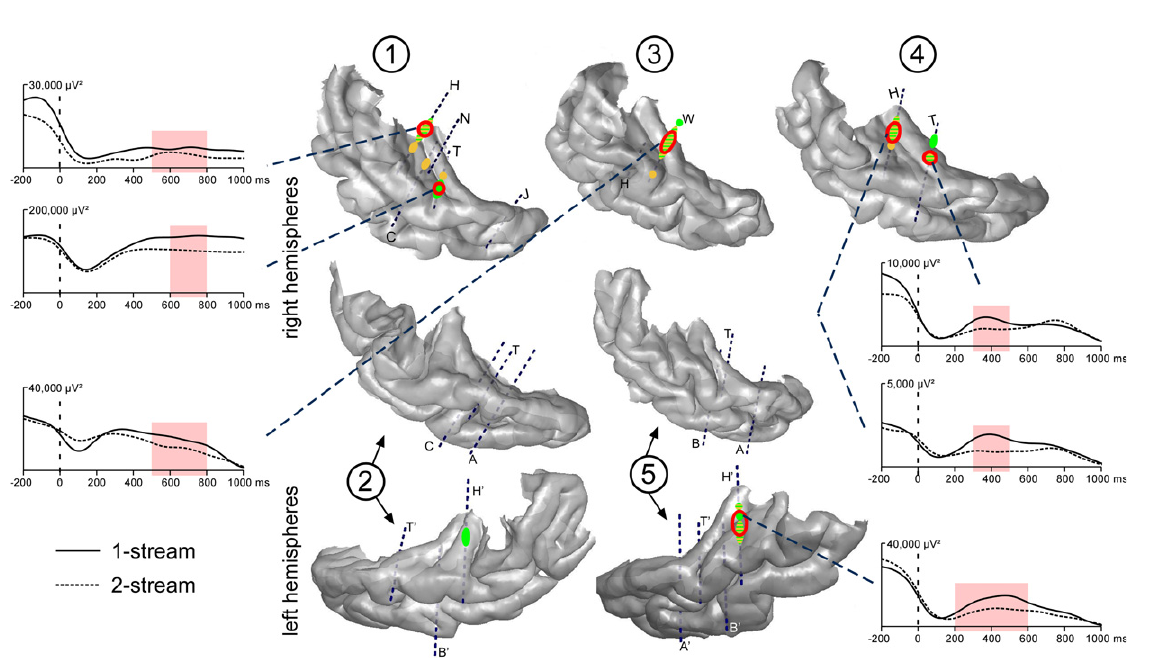
Figure 4. Emergence and modulations of evoked steady-state activities on the 3D rendering of individual temporal cortices. Emergence after the onset of part 2 (0 ms) are depicted on the temporal cortices, in green for 21 and yellow for 29 Hz steady-state activities. A fi rst focus of steady-state activities was bilateral and located in the posterior part of the HG and a second one in the right hemisphere only, in a more anterior part of the HG. Twenty-one hertz activities were found to be enhanced in the 1-stream condition, in four patients (‘1-stream > 2-stream’, red circles). Time profi les at 21 Hz of these effects are plotted (signifi cant differences are defi ned by light-red shaded areas). The power of these oscillatory activities is baseline corrected with respect to the (−250, −150 ms) period preceding part 1. Forty-two hertz steady-state emergence and effects presented quite similar topographies than 21 Hz steady-state activities. Each number corresponds to a patient, patients #2 and 5 being implanted in both